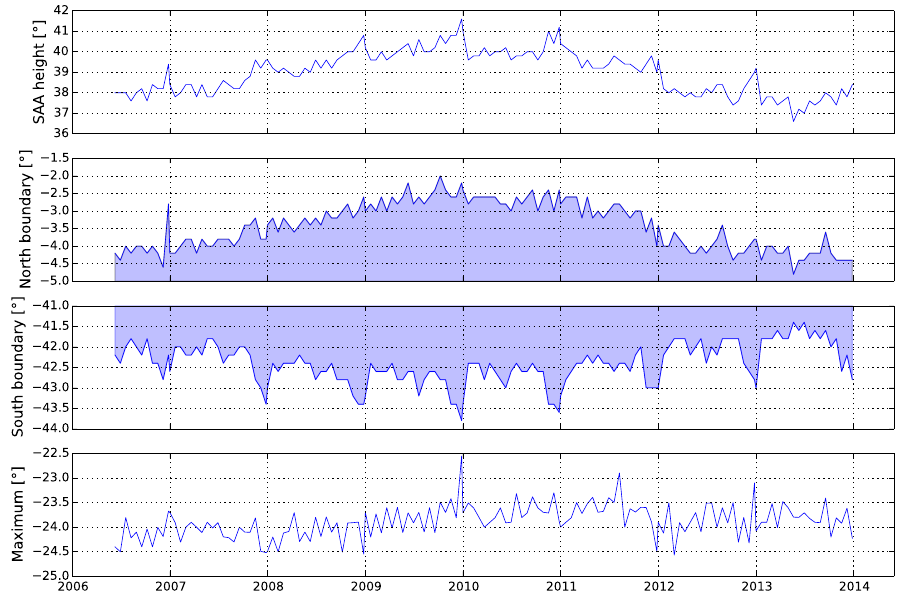
Figure 5. (top) meridional height of the SAA, defined as the region where more than 10% of profiles between 80 ◦ W and 10 ◦ W are affected by large noise. (second and third rows) north and south boundaries of the region, shaded blue inside the SAA. (bottom) latitude of the maximum fraction of noisy profiles. ! !